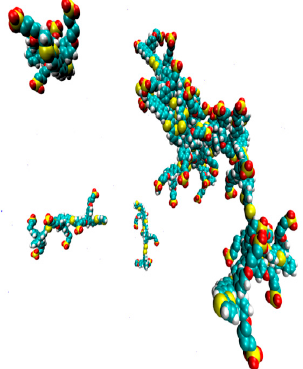
Figure 2. Simulation cell representation ( a ) front view; and ( b ) side view of 680 mM C 12 E 5 with two equivalents of PBS-PF2T at 0 °C after 10 ns, system 1 . (PBS-PF2T is shown in van der Waals representations and solvent is omitted for clarity).